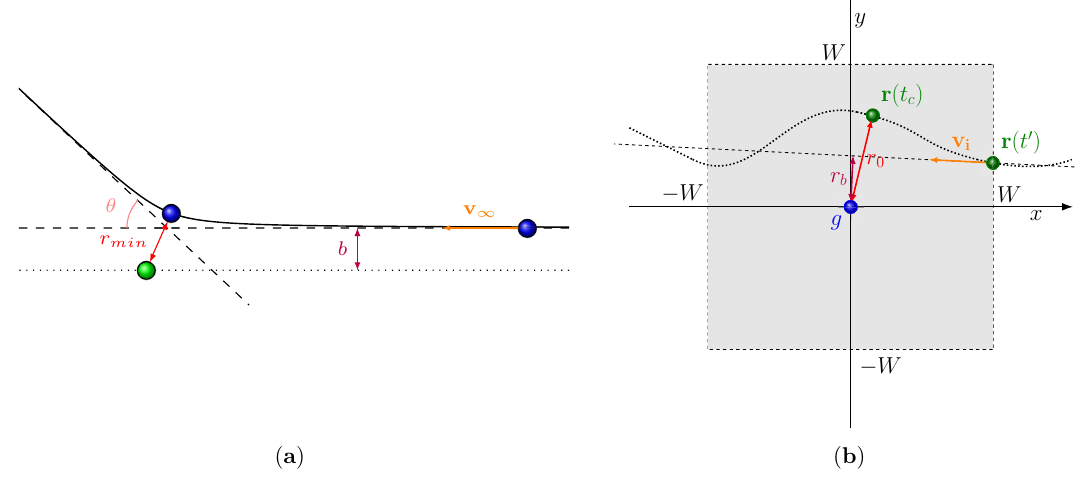
Figure 2. ( a ) Illustration of the scattering problem in physics. A mobile particle (in blue) is projected toward a fixed particle (in green). The impact parameter, b , is the straight-line distance between the particles, and r min is the closest approach. The particle is deflected with an angle θ . ( b ) A typical pedestrian avoidance situation in the group-centered reference frame . The individual enters the vicinity of the group (gray region) at time t velocity v i . The straight-line distance from the individual to the group is denoted by r b . At time t c , the individual is closest to the group at a distance of r 0